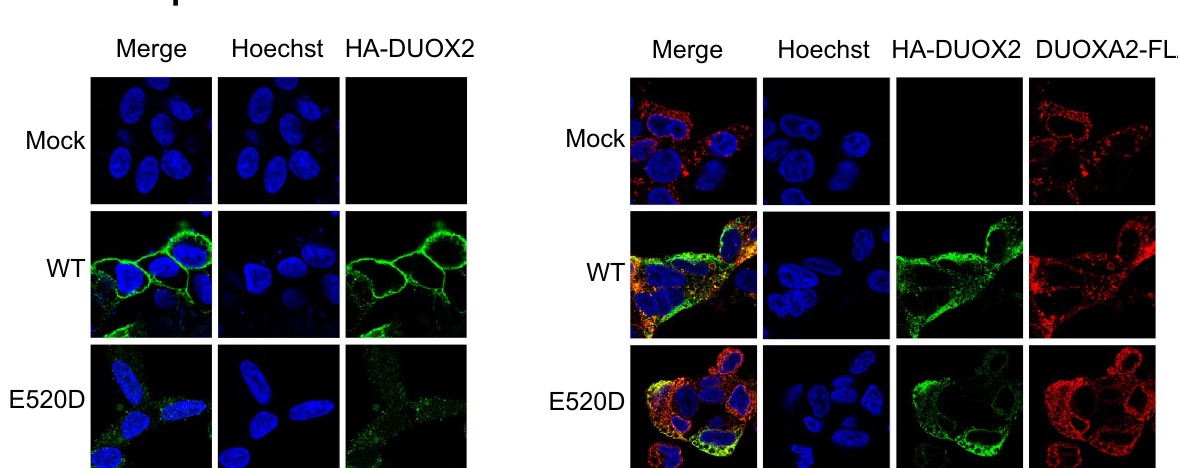
Figure 2. Clinical features and results of UPD analysis of TOKAI-IRUD-1290. (a) Brain MRI at the age of 2 years showing cortical dysplasia of the temporal lobes (arrowheads) and corpus callosum dysgenesis (arrow). (b) Results of UPD analysis. A paternally inherited UPD region over the entire length of the long arm of chromosome 15 [upd(15)pat] was identified, which covers the region of the UBE3A gene. (c) H 2 O 2 -producing capacity of the DUOX2 proteins was measured with Amplex Red reagent in the presence of co-expressed DUOXA2-FLAG. The activity of the mutants were standardized based on those of the WT (100%) and mock-transfected control (0%). Data are representative of three independent experiments (each performed in triplicate) with similar results. T-bars indicate standard errors of the mean.* p < 0 05 vs. WT (Welch’s t -test). (d) Subcellular localization analysis using HA-tagged DUOX2 constructs (WT or E520D; green fluorescence). (e) Fluorescence immunostaining under permeabilized conditions revealed that the localization of E520D-DUOX2 was consistent with